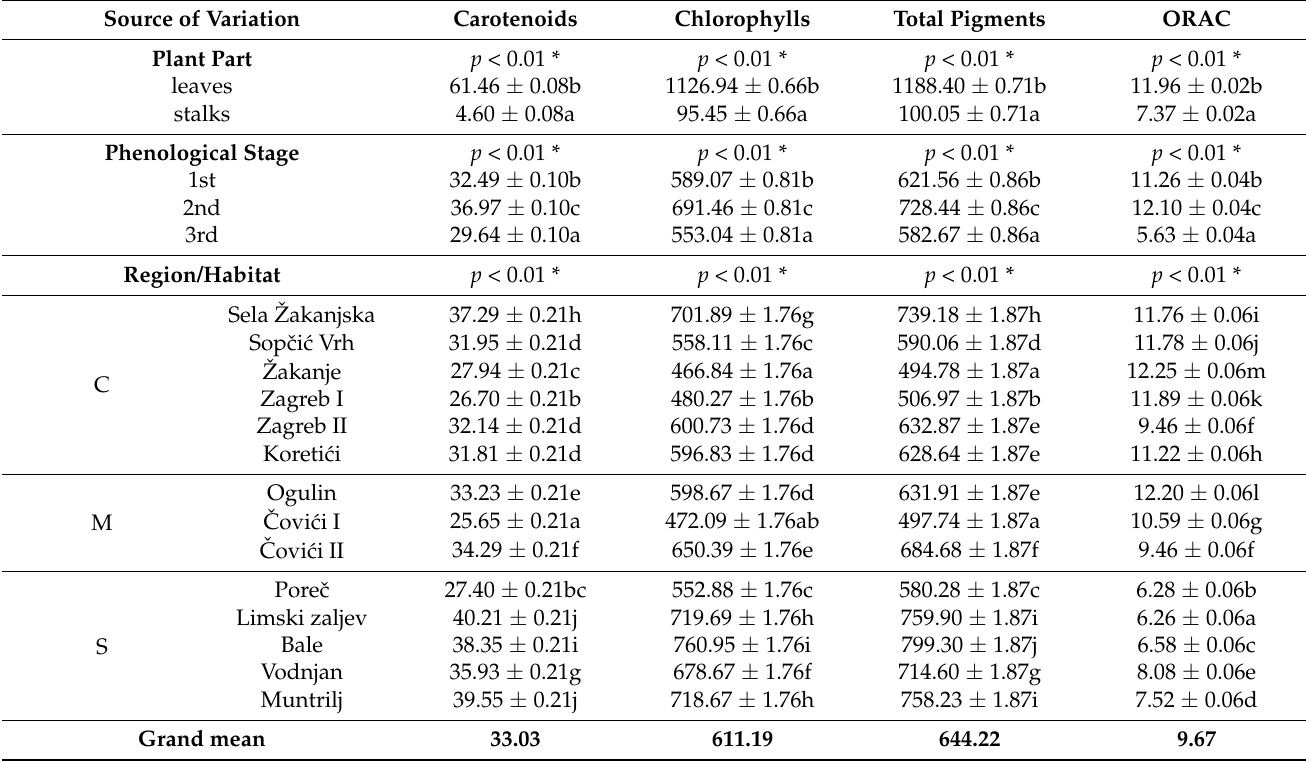
Table 4. The differences in pigments content (mg 100 g − 1 dm) and ORAC values (mmol TE 100 g − 1 dm) in wild nettle ( Urtica dioica L.) upon plant part, phenological stage and habitat. Source of Variation